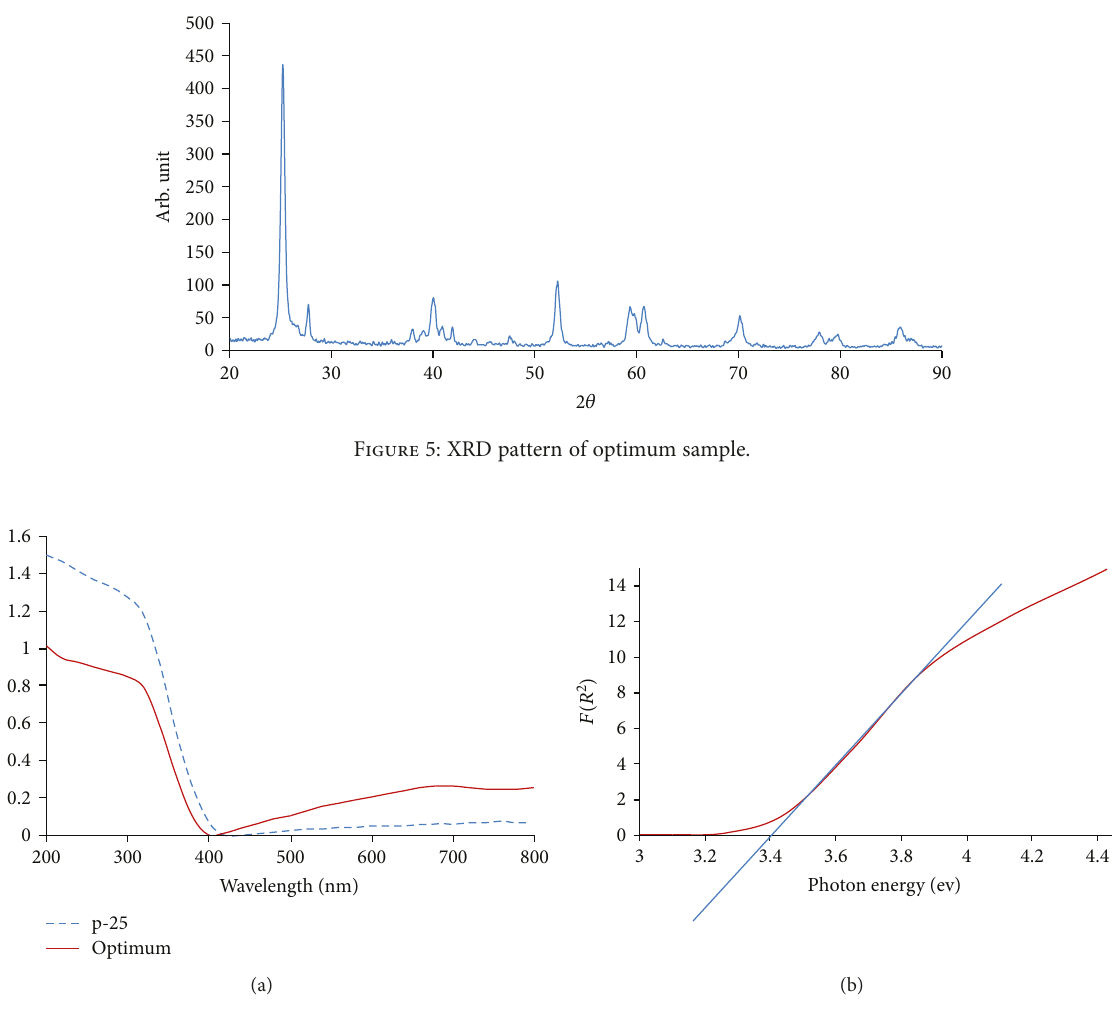
Figure 6: UV – Vis di ff use re fl ectance spectra of p-25 and optimum sample.